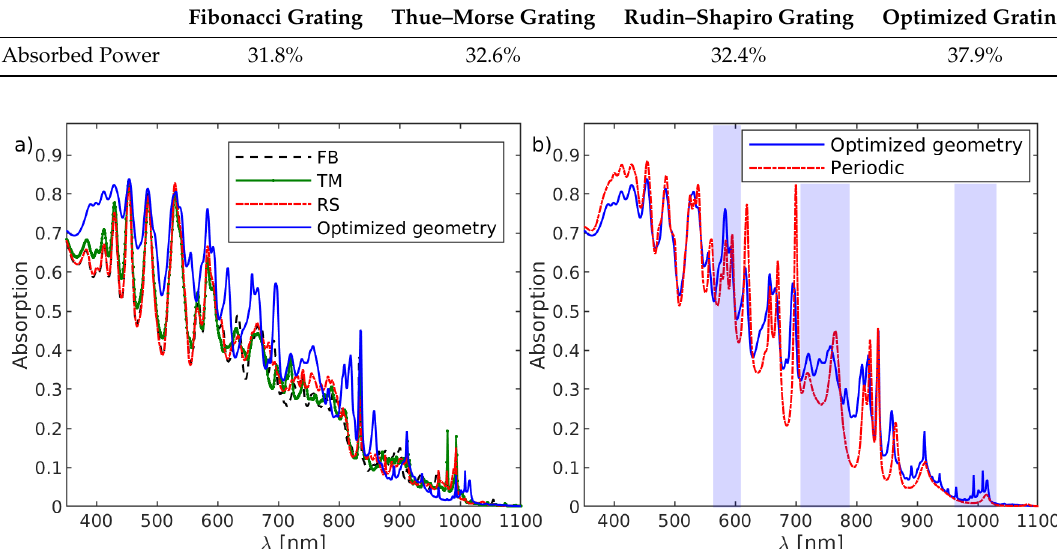
Figure 10. evaluation of optimized structures: the curve depicts the best, worst and average individual at each iteration step. Table 2. The percentage of spectrally integrated absorbed power relative to the total illuminated power for the semiperiodic double grating designs.